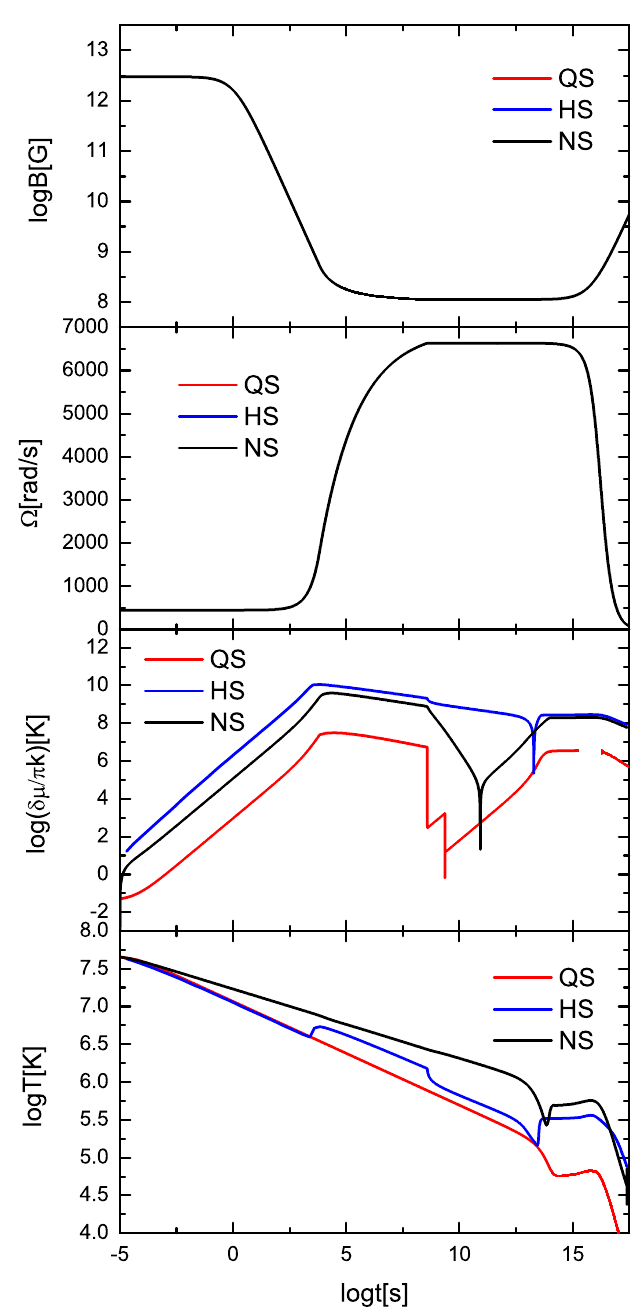
Figure 1. Surface magnetic field, spin angular frequency, chemical deviation, and surface temperature as a function of time with parameters of model 1. Pure neutron star, pure quark star, and hybrid star are represented by black line, red line, and blue line, respectively. The units of the temperature, chemical deviation, magnetic field, spin angular frequency, and time are K, K, G, rad/s, and s,